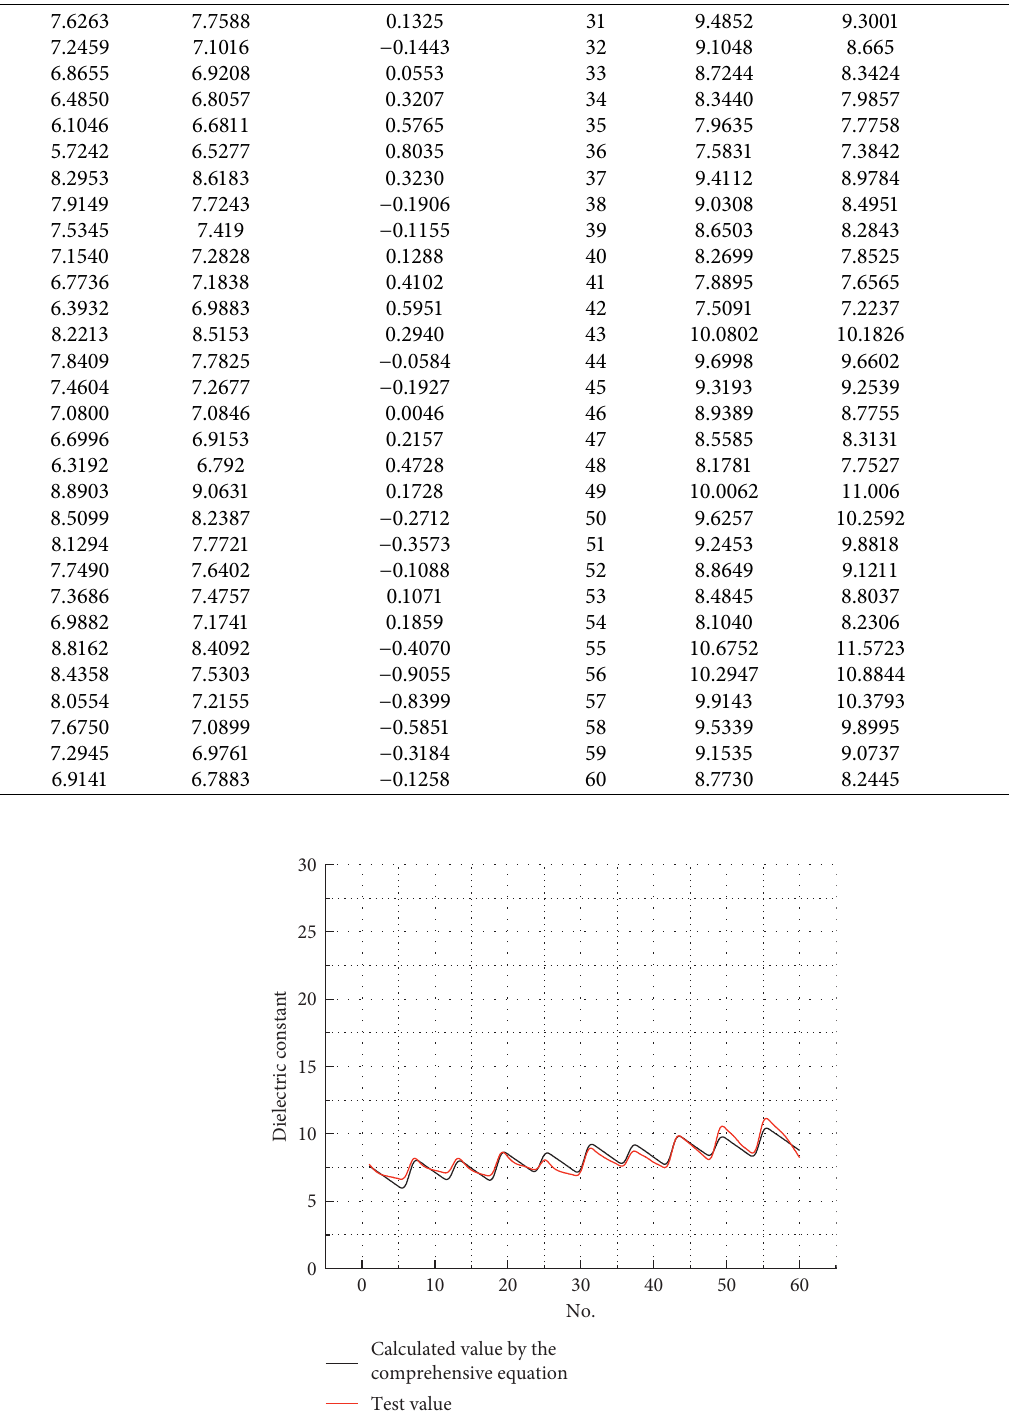
Figure 8: Comparison between the test results and calculated results using the comprehensive equation of the dielectric constant.